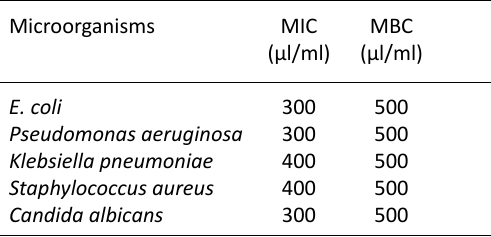
Table 4. MIC, MBC (24h) value of nanocomposite towards different microbial pathogens Microorganisms